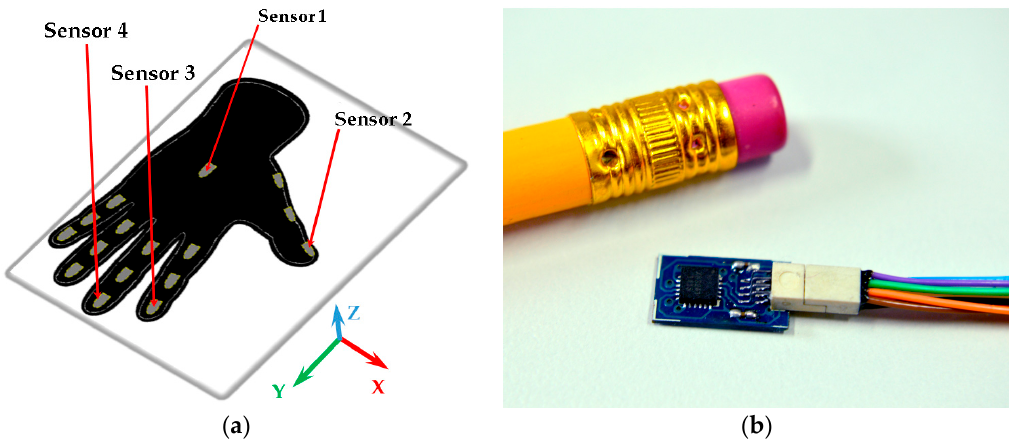
Figure 2. Sensor compartments and a motion sensor: ( a ) Distribution of sensor compartments on IGlove. Red arrows point to compartments used to accommodate the four sensors employed in this study; Sensor 1 is in the back of the hand, Sensor 2 on the thumb, Sensor 3 on the index, and Sensor 4 on the middle finger. 16 gray marks on glove indicate available places to put motion sensors (The glove has 16 compartments to put sensors, three for each finger on each phalange, and one in the back of the hand); ( b ) A sensor beside a 6 mm pencil to illustrate size. This sensor finely fits on any of the compartments on the Glove.